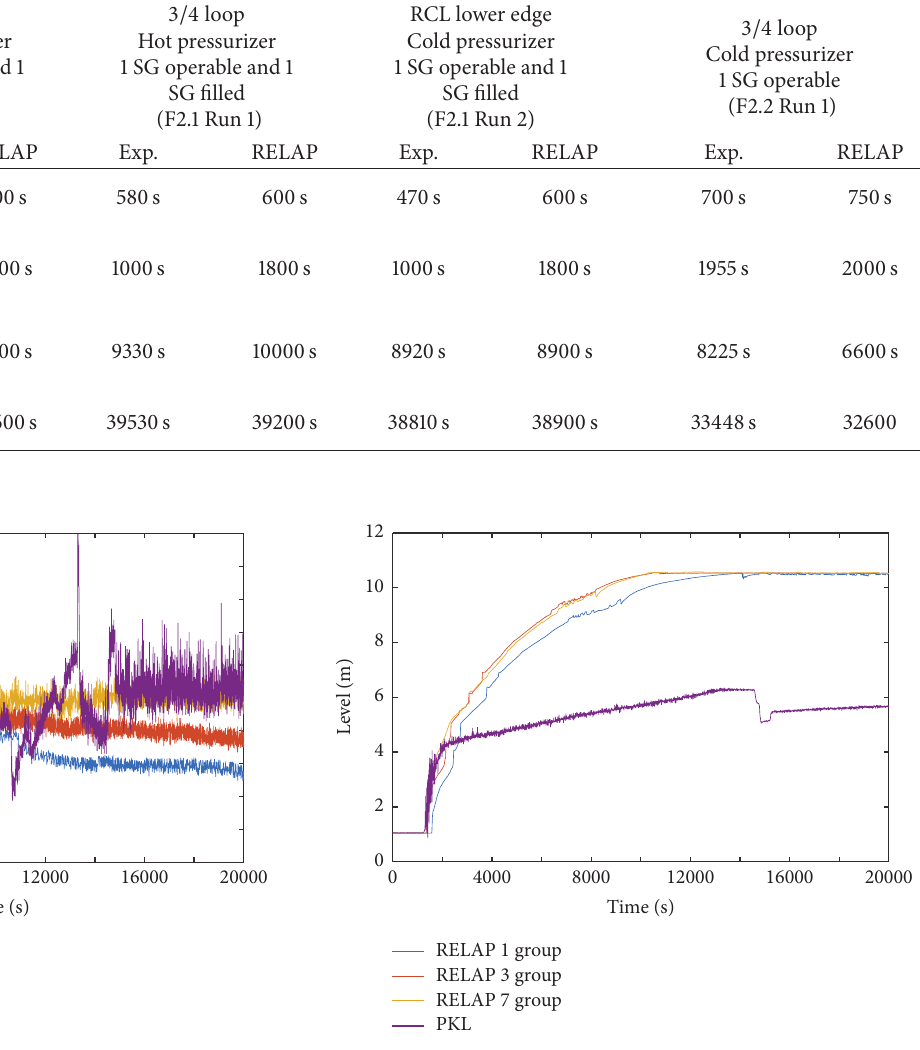
Table 3: Most important events.